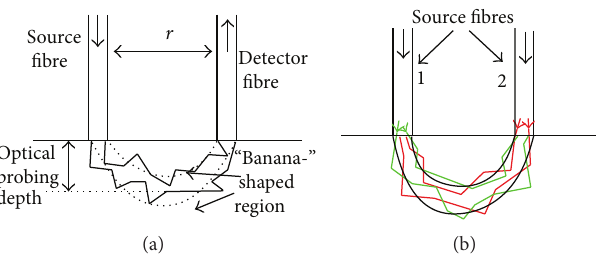
Figure 1: The most probable photon path distribution for (a) photons migrating from the source fibre to detector fibre, where the most probable area is limited by a “banana-” shaped region (dotted line) and (b) for photons migrating from two source